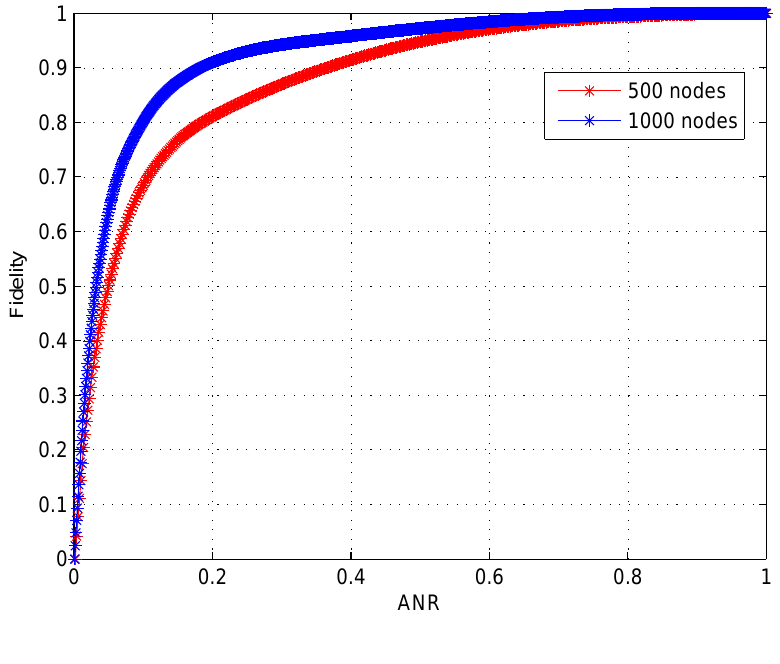
Figure 9. Structure fidelity vs. ANR. Table 2. Nodes contribution rate with different active node